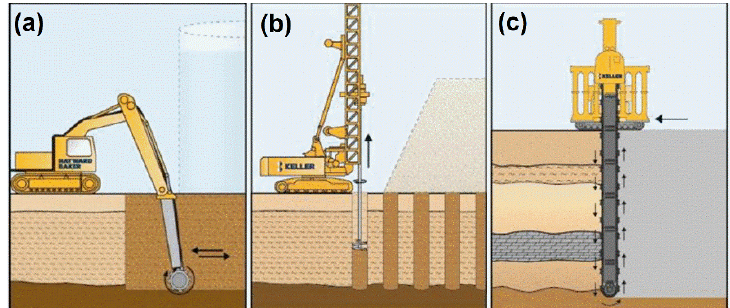
Figure 7. DSM technique: ( a ) DSM blocks, ( b ) DSM columns, and ( c ) DSM panels (courtesy of Keller).